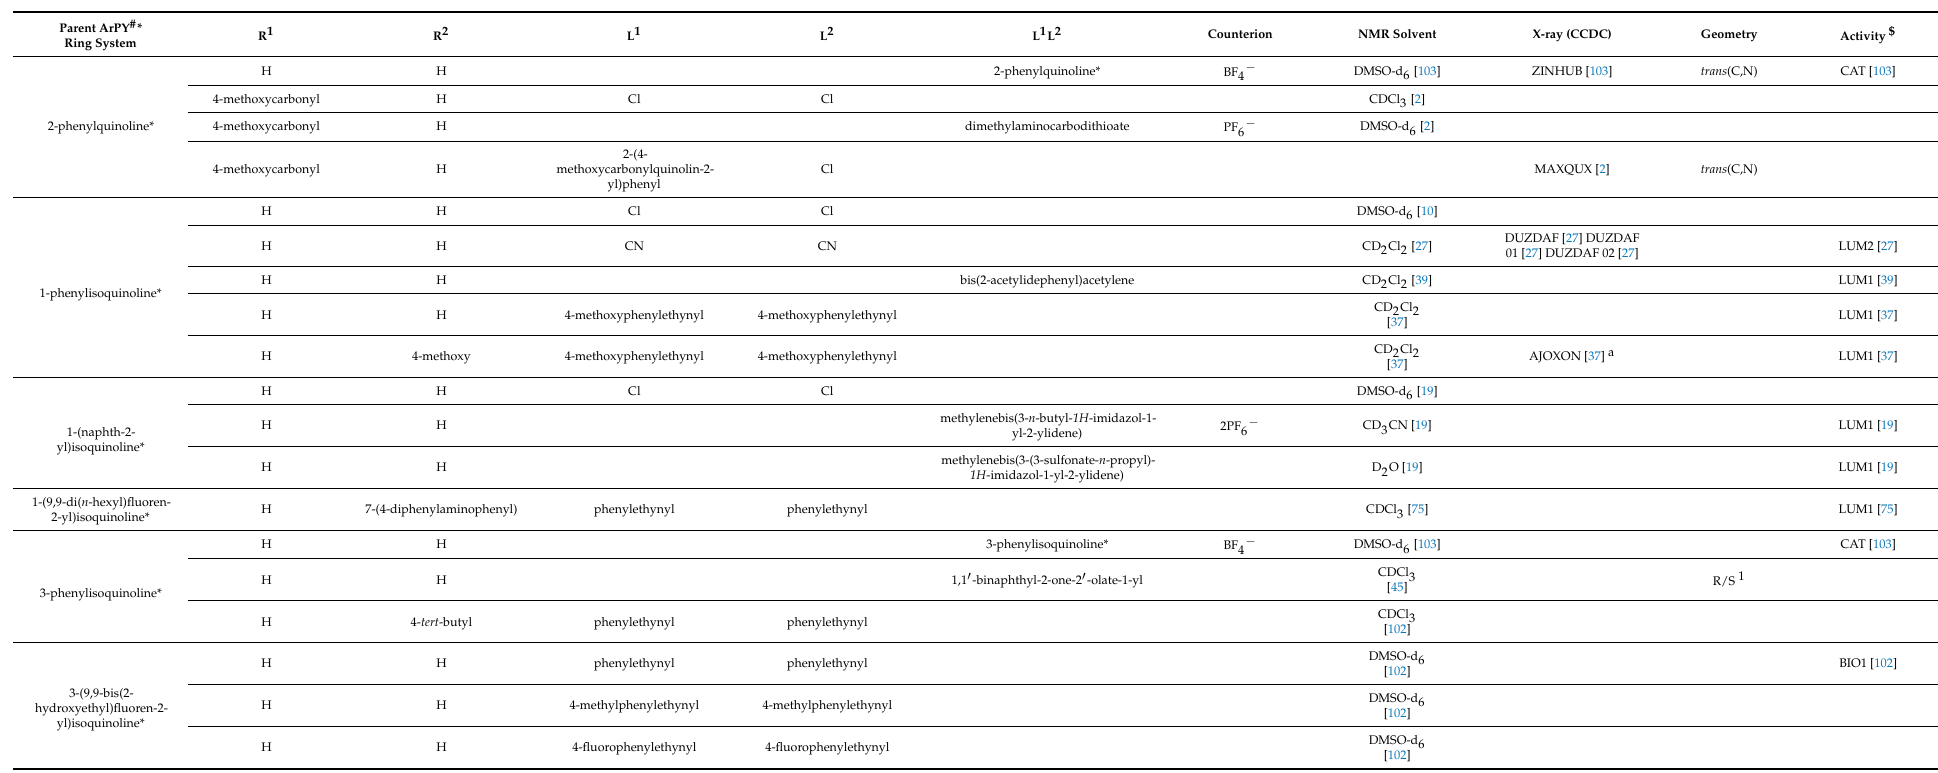
Table 6. NMR and/or X-ray studied [Au(ArPY # *)L 1 L 2 ] (in particular, [Au(ArPY # *)L 2 ]) or [Au(ArPY # *)(L 1 L 2 )]) (in particular, [Au(ArPY # *)(LL)]) compounds (ArPY # * (cid:54) = 2PPY*, 2ArPY*; L 1 , L 2 , L—monodentate ligands (including F, Cl, Br, I); LL—bidentate ligands); R 1 and R 2 are substituents in the pyridine-like ring and the